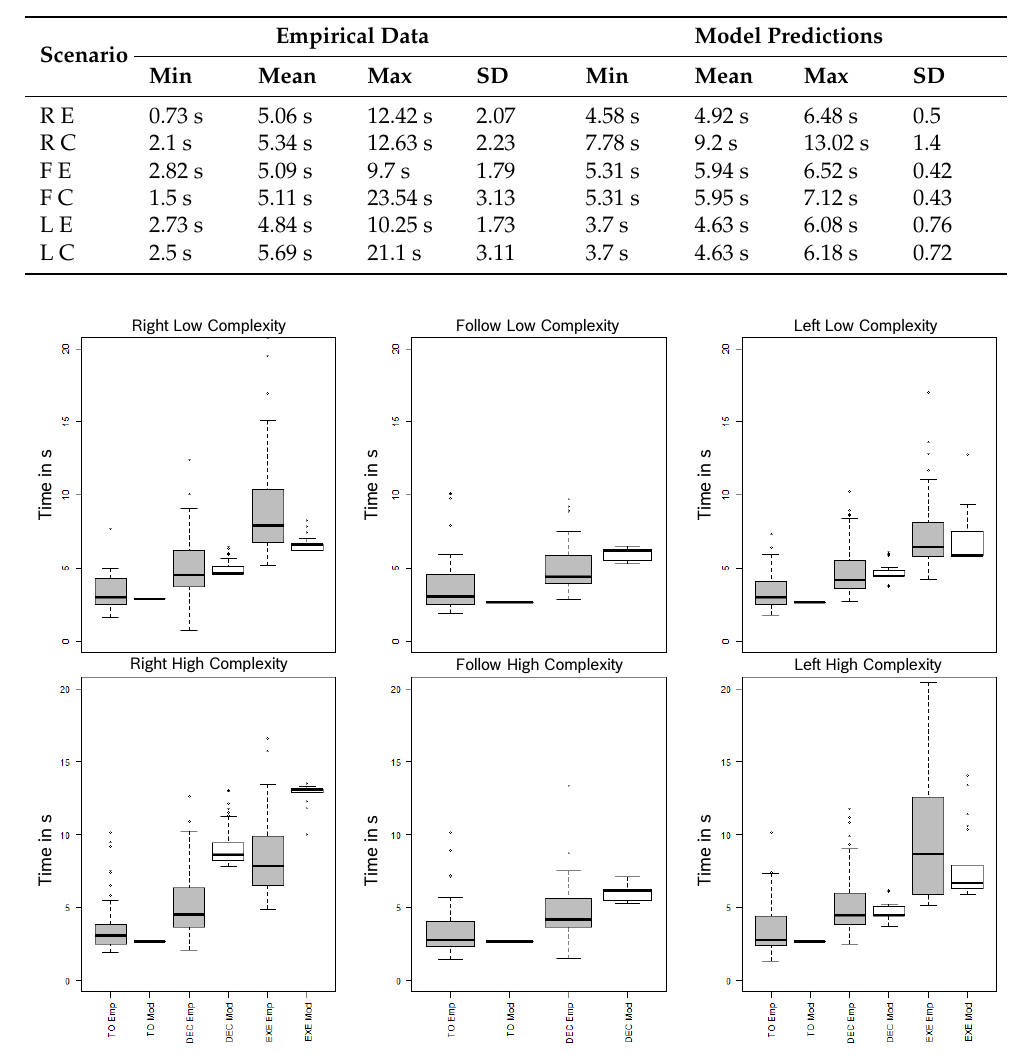
Table 4. Action decision (including wrong decision) times of empirical data vs. model predictions.